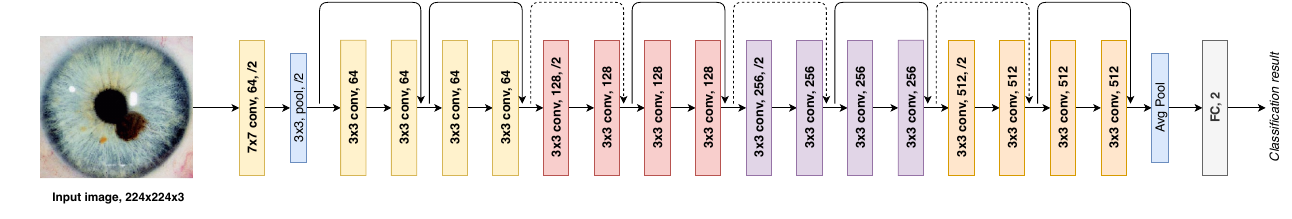
Figure 3. Resnet18